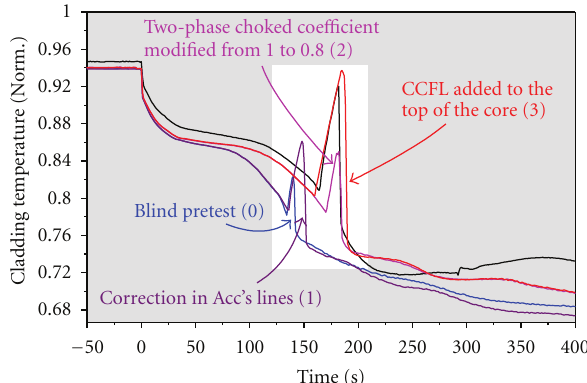
Figure 15: Maximum PCT for Test 1, evolution of the results with di ff erent modifications.